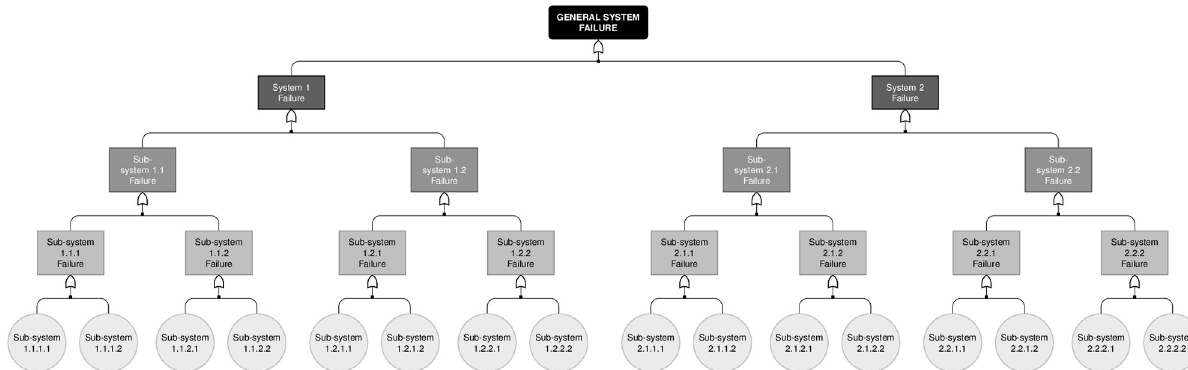
Fig 5. Proposed failure structure. Simulated failure structure for Scenarios 4, 5 and